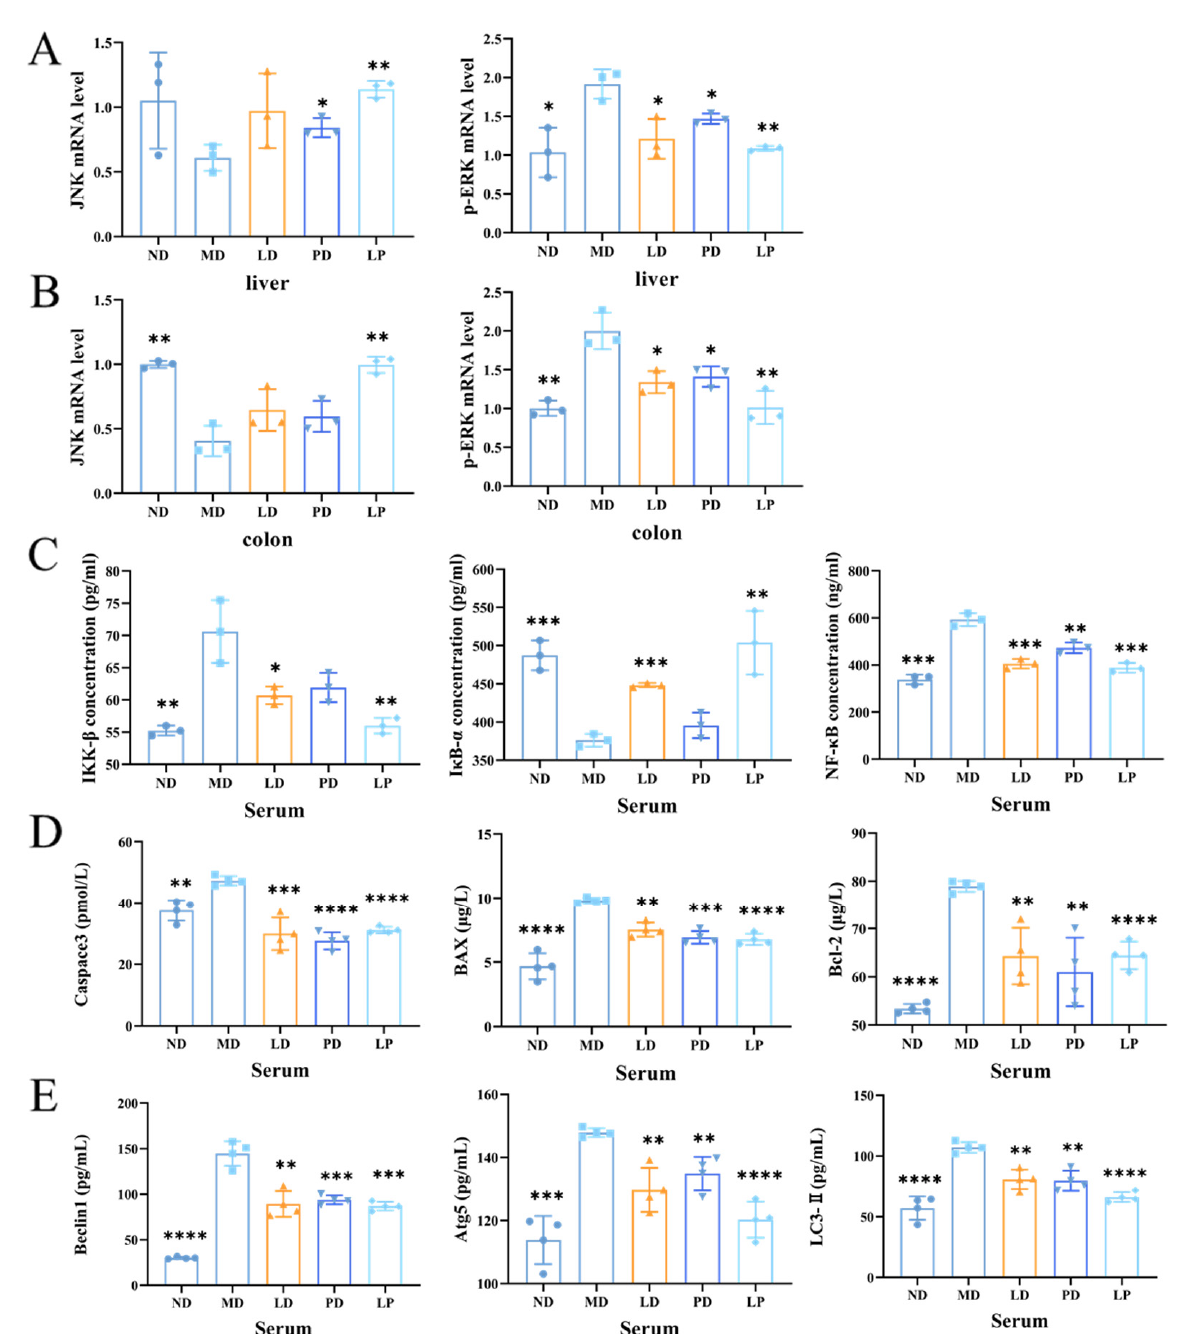
Figure 6. Synbiotics inhibited the MAPK/NF- κ B signaling pathway, then inhibited the apoptotic signaling pathway and the autophagic signaling pathway in CCl 4 -induced ALI mice. ( A , B ) mRNA levels of the MAPK signaling pathway-related genes in the liver ( A ) and colon ( B ) ( n = 3). ( C – E ) Quantitative analysis of protein expressions of NF- κ B signaling ( C ), apoptotic signaling ( D ), and autophagic signaling ( E ) pathway-related proteins ( n = 3–4). * p < 0.05; ** p < 0.01; *** p < 0.001; **** p < 0.0001; * is compared with MD; paired two-tailed t -test.